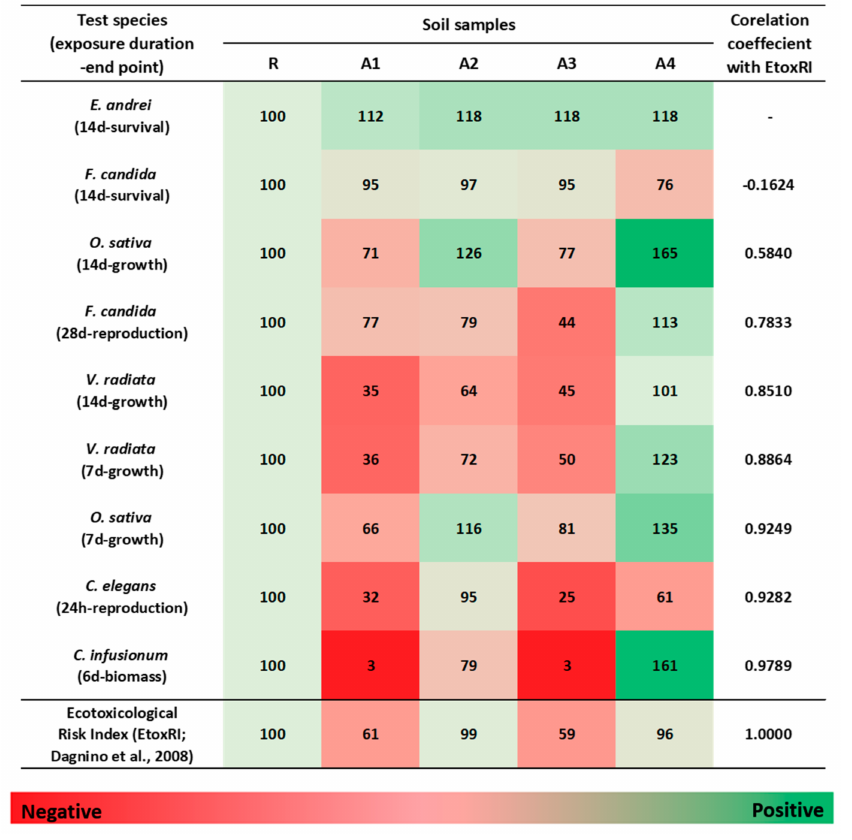
Figure 3. Comparison of each bioassay and the ecotoxicological risk index (EtoxRI). To compare with bioassay results, the EtoxRI (calculated as 0–1 in this study) was converted to a percentage of the R soil (control). Red and green colors denote negative and positive effects, respectively. The test species are placed in the order of the correlation coefficients calculated from the correlation with the EtoxRI. The higher the correlation with the EtoxRI, the lower it is placed. The right-most column presents the correlation coefficients of the EtoxRI and the bioassay